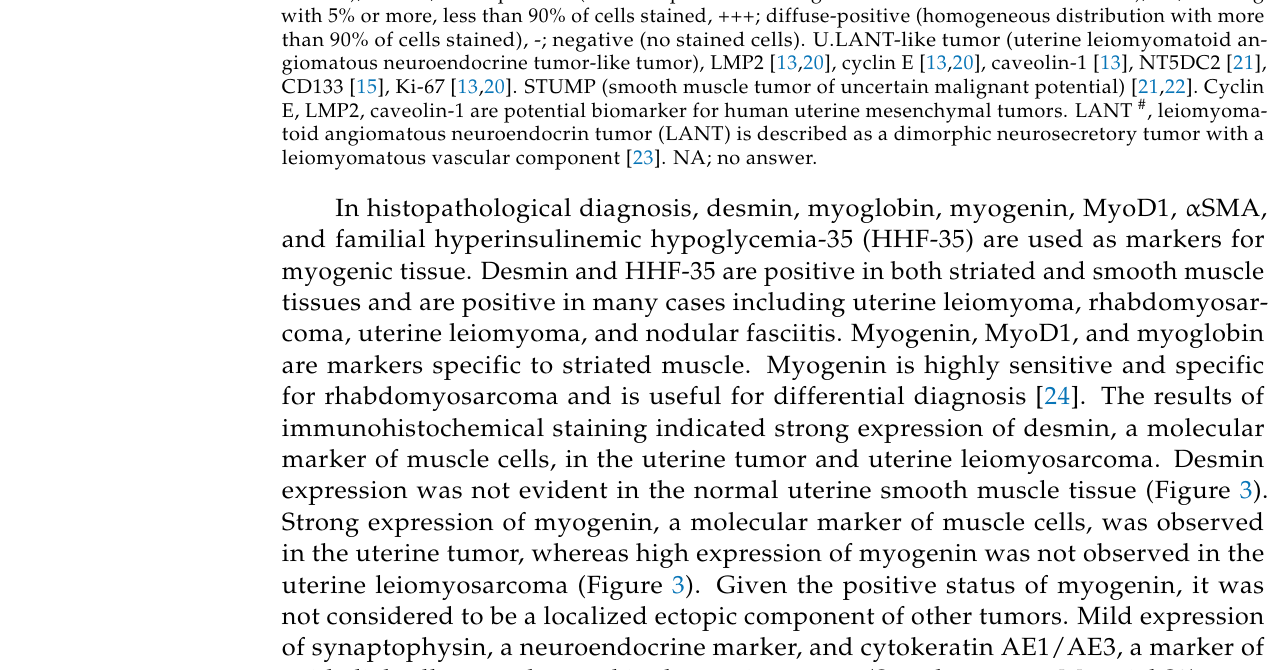
* Staining score of expression of SMA (smooth muscle actin), CAV1 (caveolin-1), CCNB (cyclin B), CCNE (cyclin E), LMP2 (low molecular protein 2), NT5DC2 (5’-nucleotidase domain containing 2) and Ki-67 from results of IHC experiments. Protein expression *; estimated-protein expressions by immunoblot analysis, immunohistochemistry (IHC) and/or RT-PCR (quantitative-PCR), -/+; partially positive (5% to 10% of cells stained), Focal+; Focal-positive (focal or sporadic staining with less than 5% of cells stained), ++; staining with 5% or more, less than 90% of cells stained, +++; diffuse-positive (homogeneous distribution with